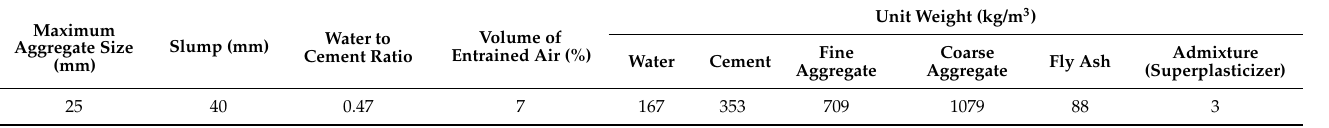
Table 2. Mixture design